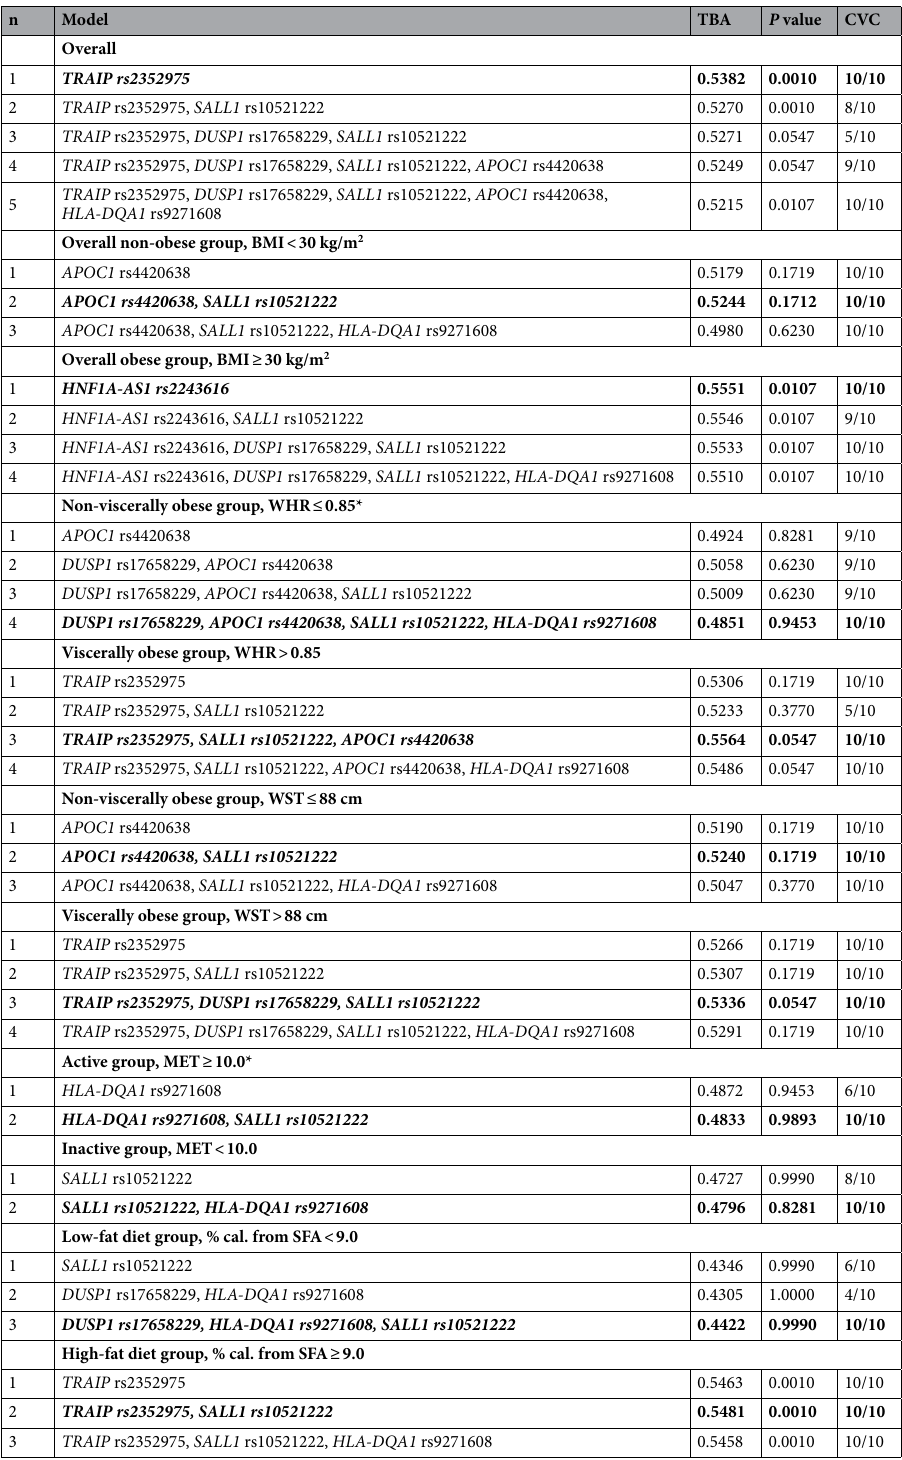
Table 3. GMDR-based model for high-order gene–gene interactions in relation to breast cancer risk. BMI body mass index; CVC, cross-validation consistency; GMDR, generalized multifactor dimensionality reduction; MET, metabolic equivalent; SFA, saturated fatty acids; TBA, testing balance accuracy; WHR, waist-to-hip ratio; WST, waist circumference. Models in bold face are considered the best, with the highest TBA, 10/10 CVC, and p < 0.05. *The models have either the highest TBA or 10/10 CVC, without statistical significance. By placing a greater importance on 10/10 CVC, the best model was